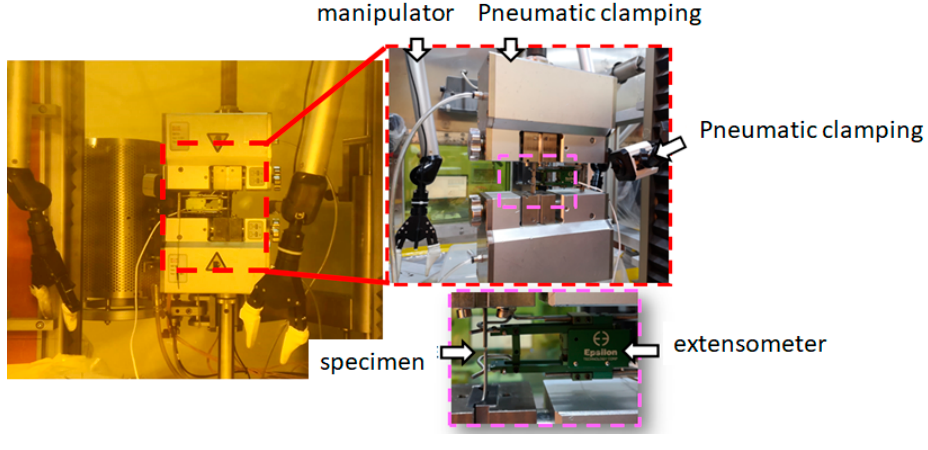
Figure 3. Tensile test machine in hot cell.